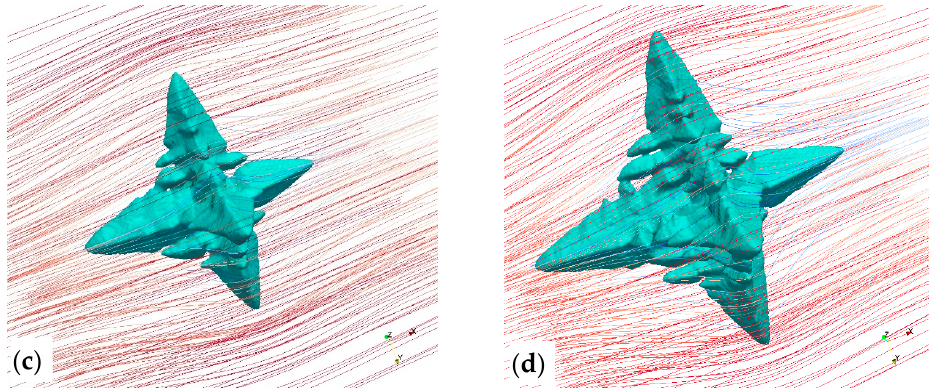
Figure 5. Evolution of dendritic structures under melt convection. Snapshots were taken after ( a ) 2 ms,